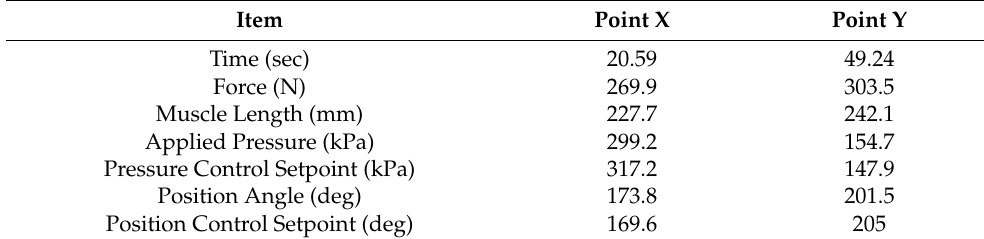
Figure 22. Dynamic external load addition and removal responses at 0.10 Hz sinusoidal position trajectory. Table 6. Numerical values for critical points marked in Figure 22.